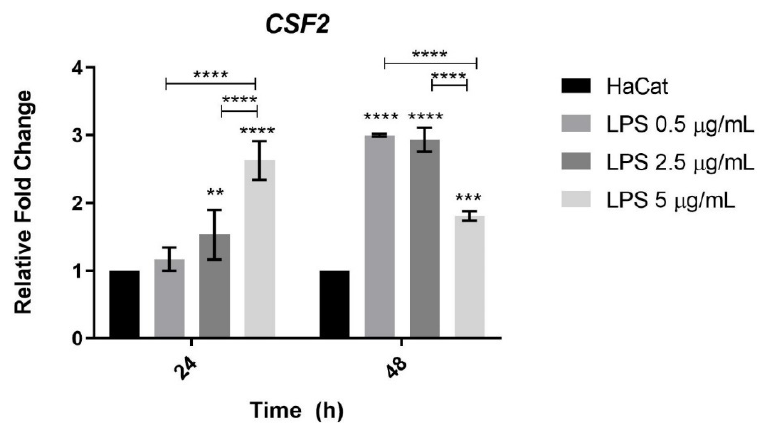
Figure 5. CSF2 gene expression levels in human keratinocytes challenged with LPS. HaCat: keratinocytes were used as control. Three different concentrations of LPS were tested (0.5, 2.5, and 5 µg/ mL). Asterisks indicate significant differences (** p < 0.01; *** p < 0.001; **** p < 0.0001).